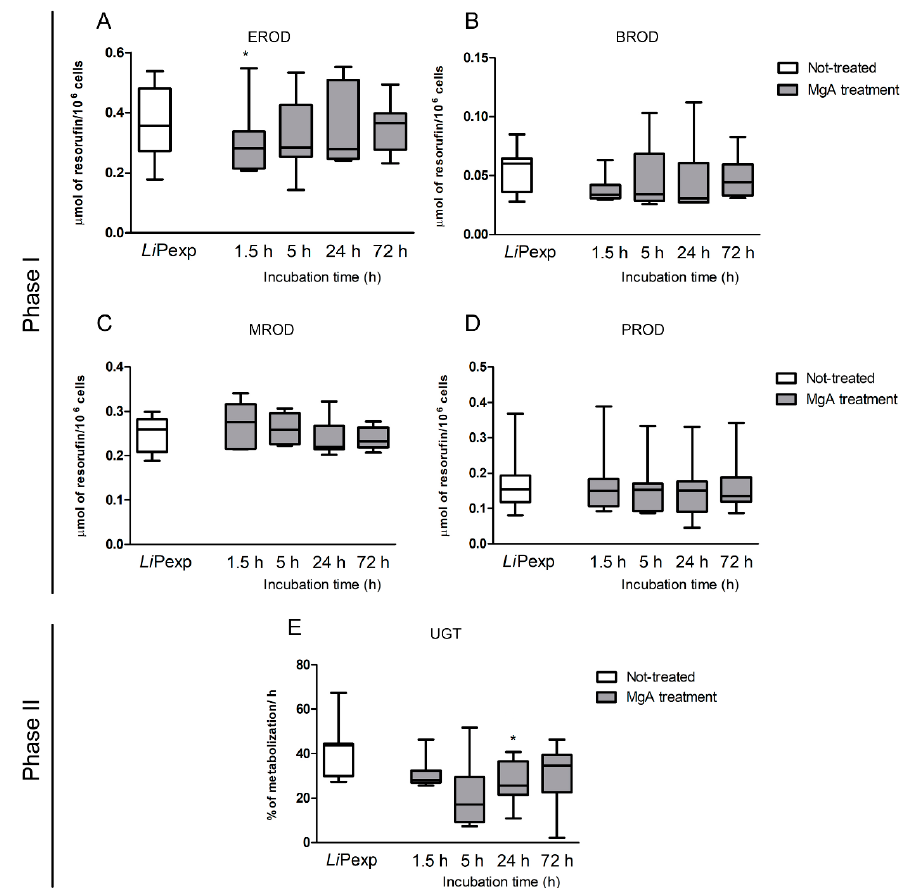
Figure 7. Phase I and phase II enzyme activity after MgA treatment of hepatic spheroids exposed to L. infantum axenic promastigotes. Samples of 3D-culture supernatants were used to evaluate EROD ( A ), BROD ( B ), MROD ( C ), PROD ( D ), and UGT ( E ) enzyme activity at 1.5, 5, 24, and 72 h of MgA treatment. Untreated hepatocyte aggregates exposed to parasites for 72 h ( Li Pexp) also were evaluated. Results of 10 dogs performed in triplicate are represented by box plots, whiskers (minimum to maximum), and medium. The non-parametric Wilcoxon test was used for statistical comparisons, and * indicates statistically significant values ( p < 0.05) when comparing untreated vs. treated amastigote-exposed